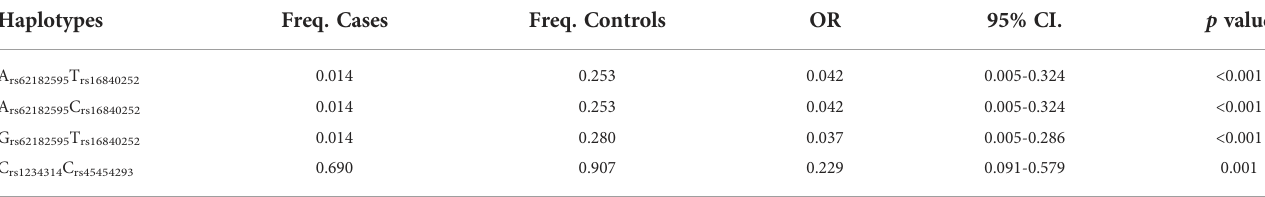
Freq., frequency; OR, odds ratio; CI, con fi dence